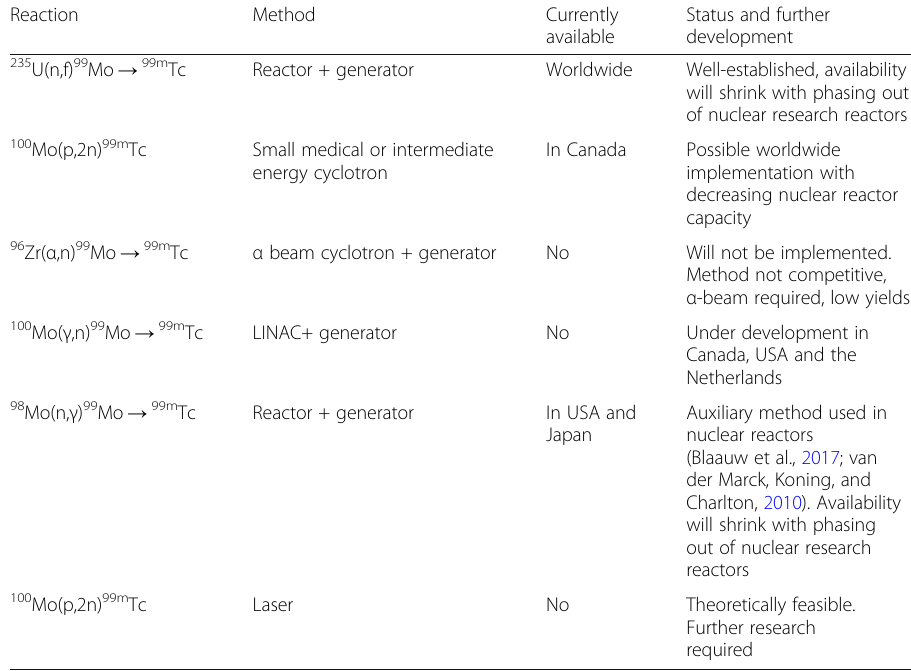
Table 3 99m Tc production